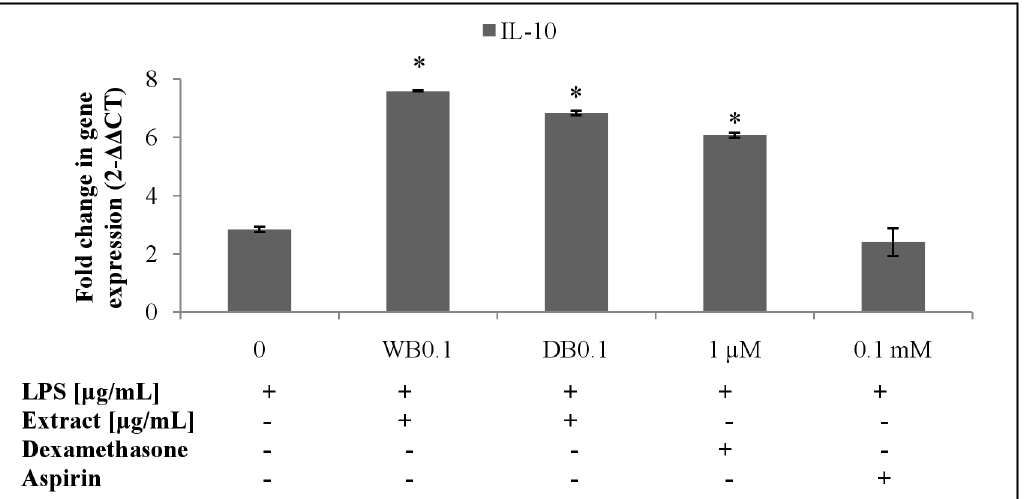
Fig 10. Effects of A . rugosum extracts on IL-10 gene expression (S1 Dataset). RAW264.7 cells were co-incubated with A . rugosum extracts (WB0.1: 0.1 μ g/mL WB; DB0.1: 0.1 μ g/mL DB) and 1 μ g/mL LPS for 24 hrs. Dexamethasone (1 μ M) and aspirin (0.1 mM) served as positive controls. β -actin was used as loading control and normalised against the treated group. Results shown represent the mean ± SD, n = 3 and * p < 0.05 versus LPS-induced NO level alone.